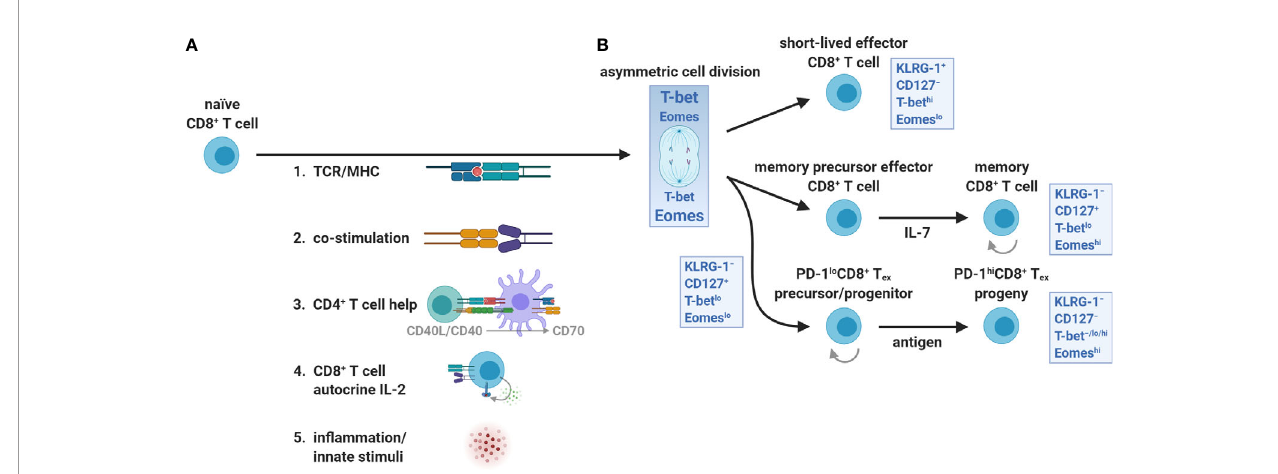
FIGURE 3 | T-bet and Eomes partitioning during CD8 + T cell priming and expansion. (A) The orientation and strength of TCR/MHC ligation, co-stimulation ( e.g. , CD28 interaction with CD80 and CD86), CD4 + T cell help (CD40L/CD40 licensing of DCs including up-regulation of MHC I, CD80/CD86, CD70, and third signal cytokines), autocrine IL-2 exposure, and innate in fl ammatory stimuli (danger- and pathogen-associated molecular patterns) all in fl uence the activation, survival, and differentiation of naïve CD8 + T cells. (B) CD8 + T cells integrate these input events at priming and during the fi rst division. The uneven partitioning of T-bet and Eomes favors SLEC (effector) versus MPEC (memory) differentiation early after activation, respectively. In contrast, the CD8 + T ex lineage requires both transcription factors and retains some features of memory cells including self-renewal of PD-1 lo subsets and expression of memory-associated transcription factors and survival molecules. The reliance on homeostatic cytokines (predominantly IL-7) versus persistent antigen for development and self-renewal distinguishes memory from PD-1 lo/hi exhaustion lineages,